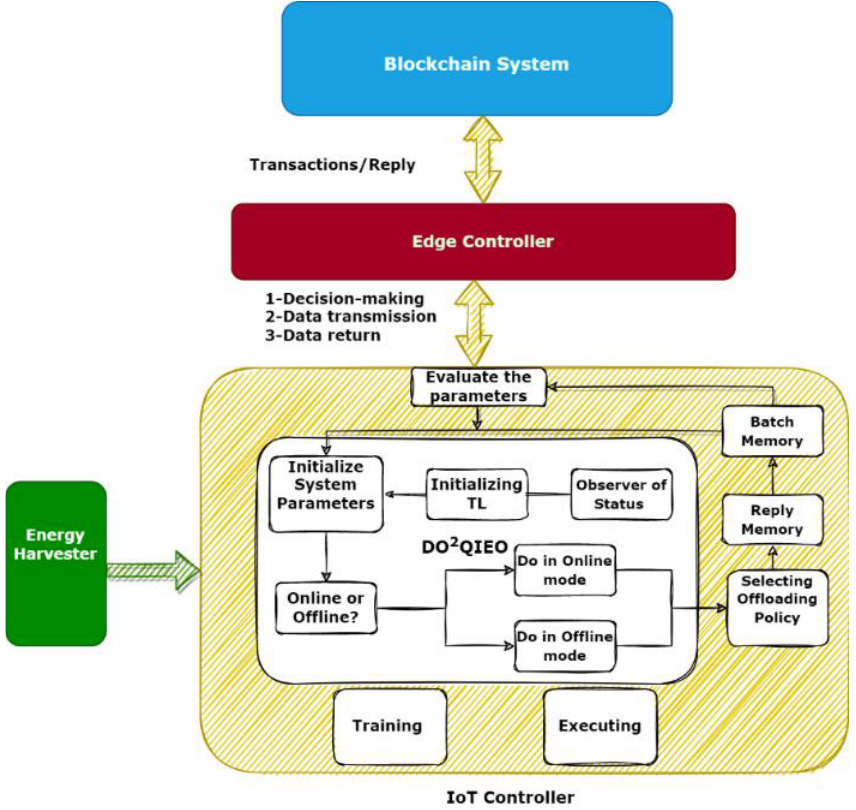
Figure 4. The DO 2 QIEO method is being used to establish a decision-making mechanism.